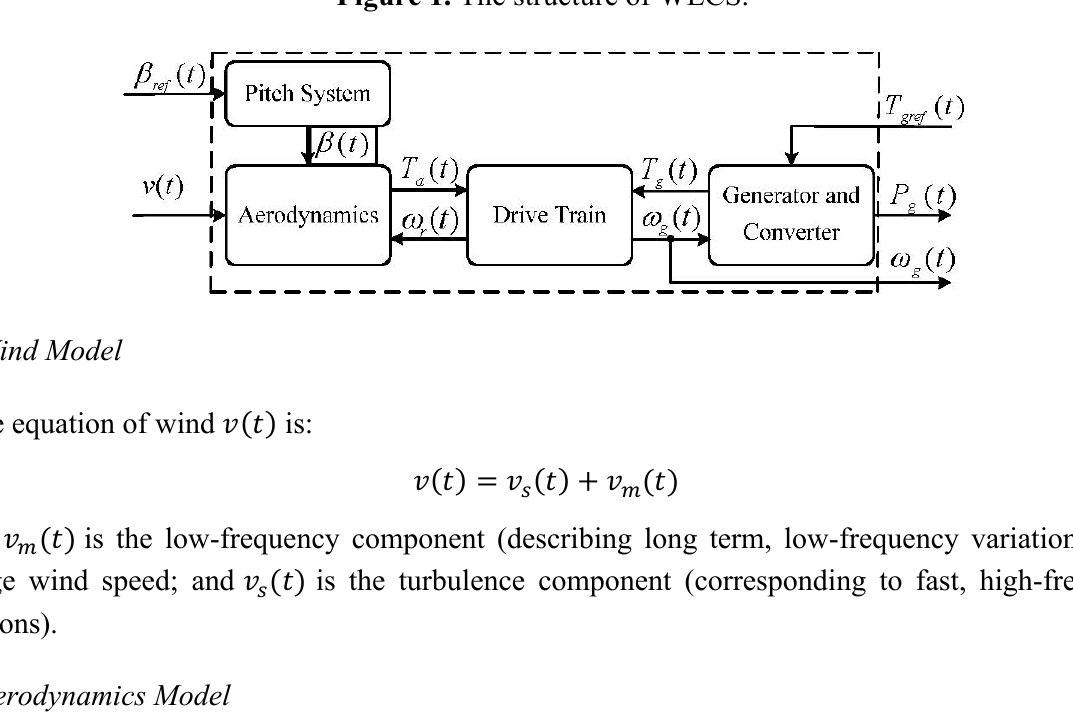
Figure 1. The structure of